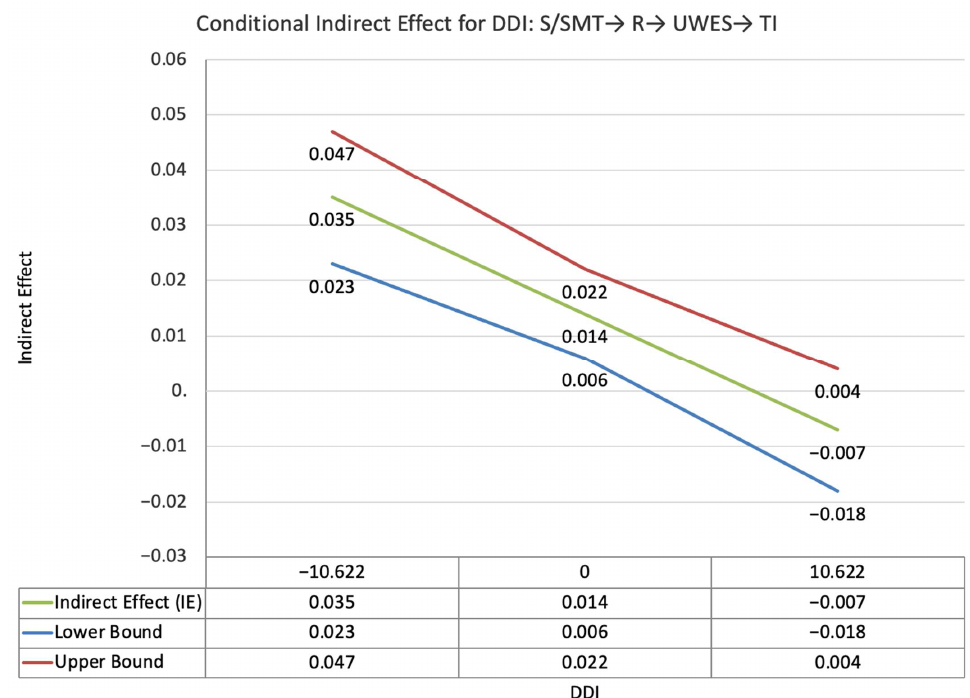
Figure 8. Conditional indirect effects of the difference between self-PMIEs compared to the control group on turnover intentions at low, average and high levels of self-disclosure, through relatedness satisfaction and burnout.